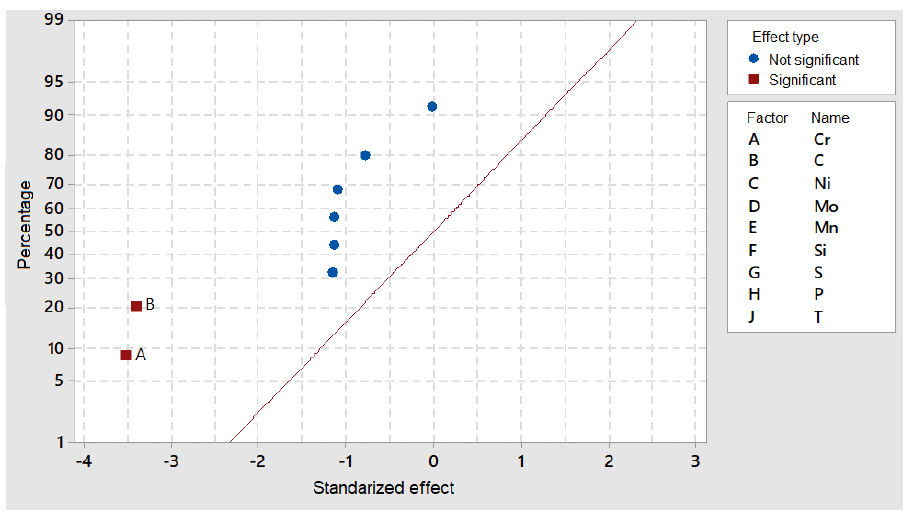
Figure 11. M 23 C 6 precipitates’ size in nanometers: standardized effects ( α = 0.05) for the DOE Thermocalc simulation.